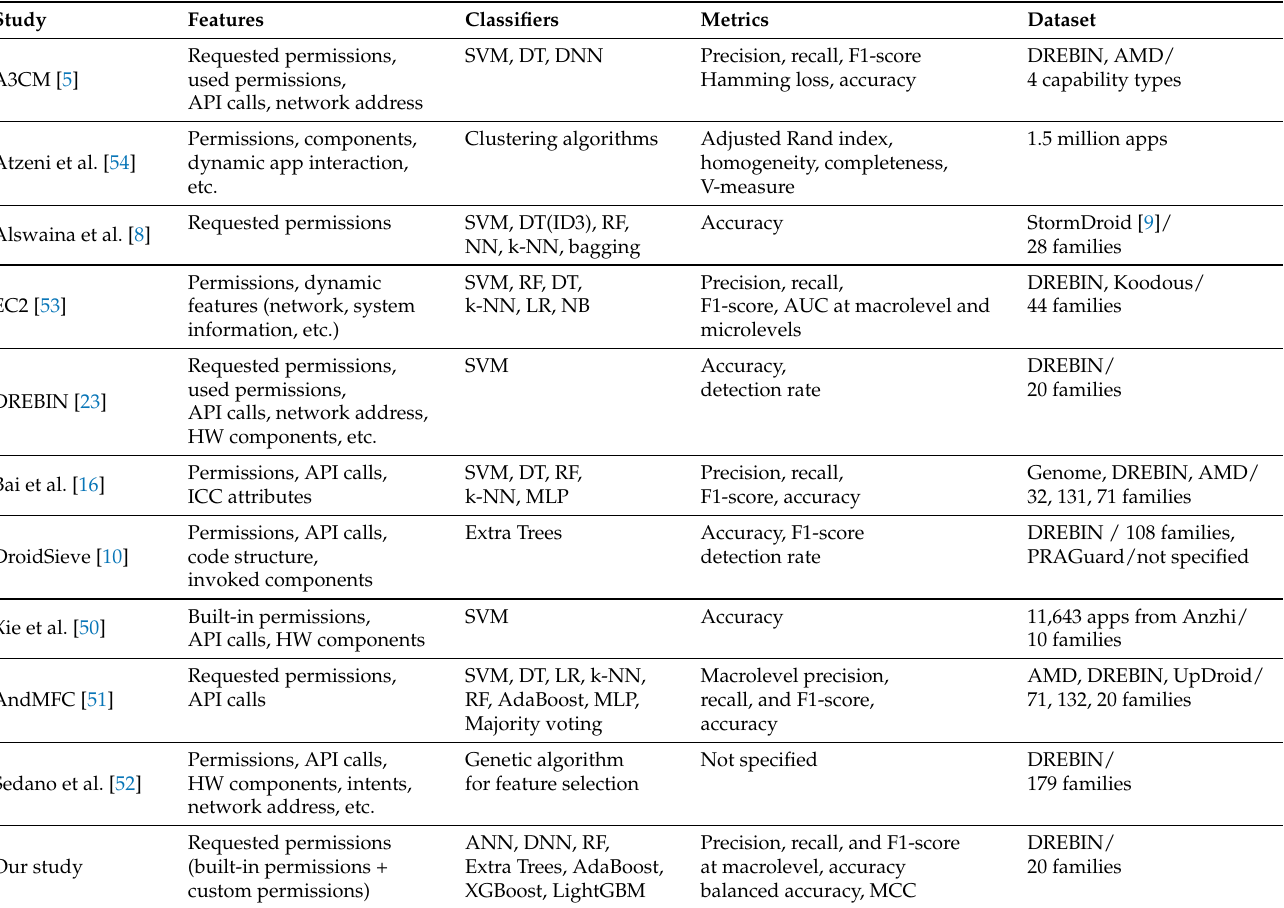
Table 4. Comparison of the studies on Android malware family classification/clustering using